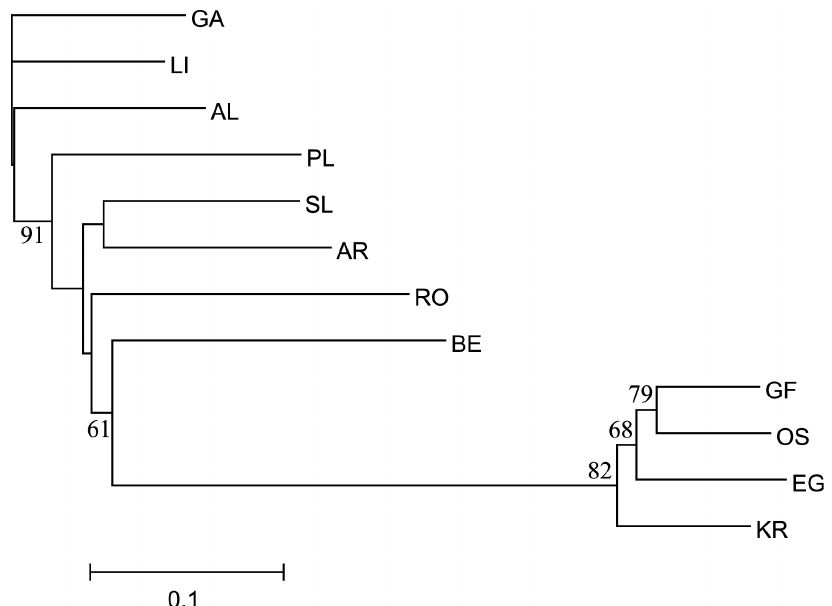
Figure 6. Phylogenetic relationship between S.melops populations. The tree topology was estimated from Cavalli-Sforza and Edward`s chord distance [37], D CE, whereas the branch lengths were extracted from Goldstein et al.’s d m 2 distance matrix [38]. Numbers next to branch are bootstrap support above 60% (1 000 replicates).